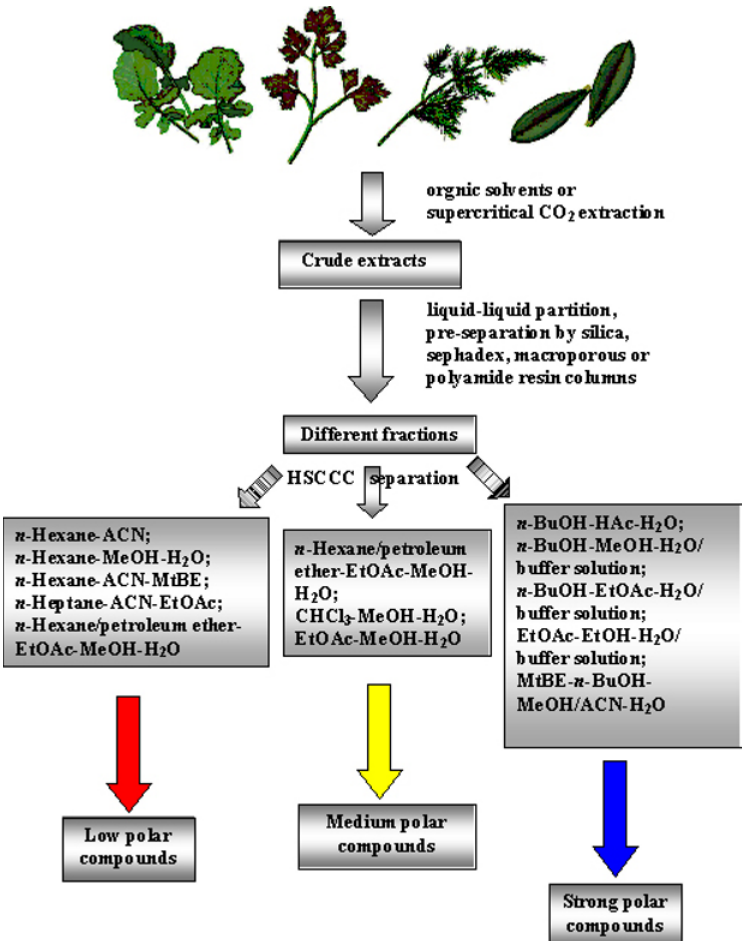
Figure 6. General procedure and recommendable solvent systems in HSCCC systematic